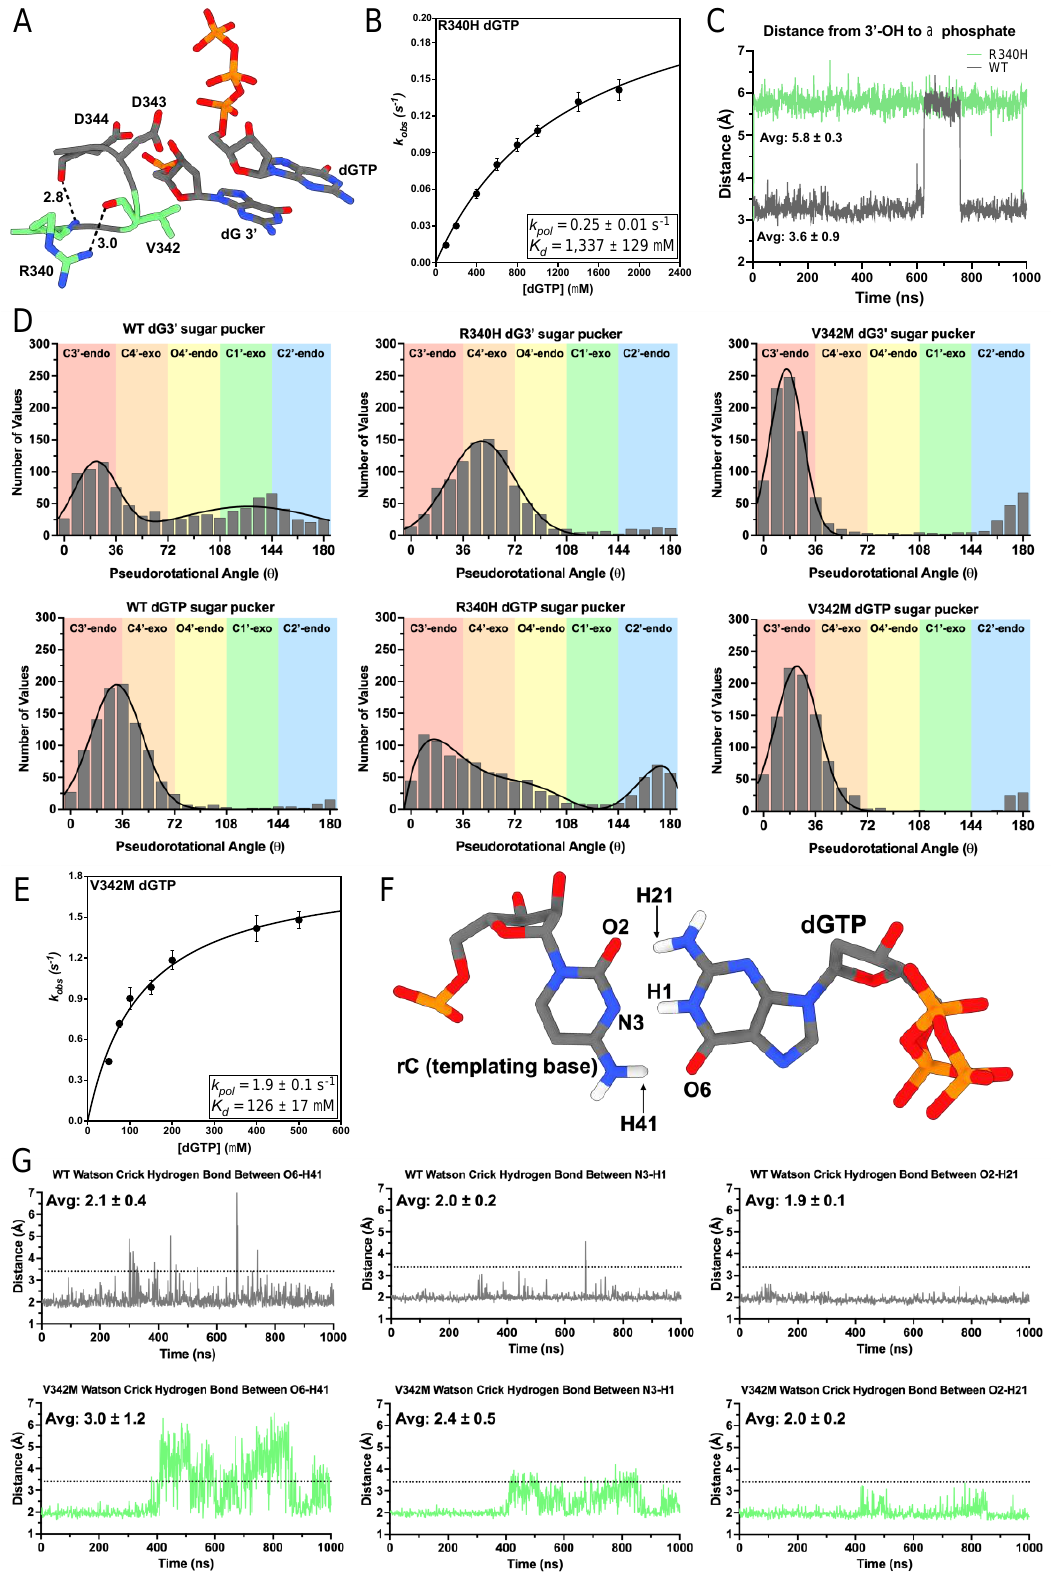
Figure 3. Mechanism of R340H and V342M nucleotide insertion. ( A ) Interactions between R340 and V342 with the 3′ terminal nucleotide (dG 3′ ) and the incoming dGTP (PDB: 7KQN). ( B ) Replot of k obs values from single-turnover kinetics of R340H inserting dGTP with the k pol and K d indicated. ( C )